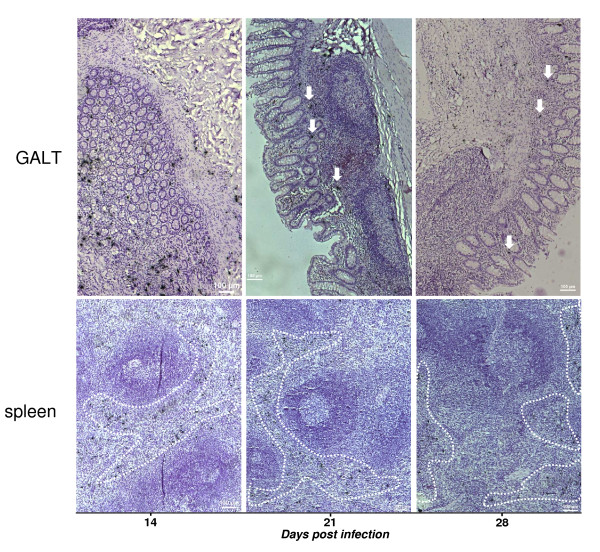
Viral transcription in the two examples of tissue, GALT and spleen, at 14, 21 and 28 days pi. In situ hybridization was performed with radiolabeled SIV-specific RNA and SIV RNA-positive cells appear black. Montage of large image (magnification ×10) of single section, among 4 or 2 sections examined from GALT and spleen, respectively. The encircled regions in the spleen were the most numerous for productive cells. The headed arrow points to a few SIV RNA positive cells founded at day 21 and 28 in the GALT.